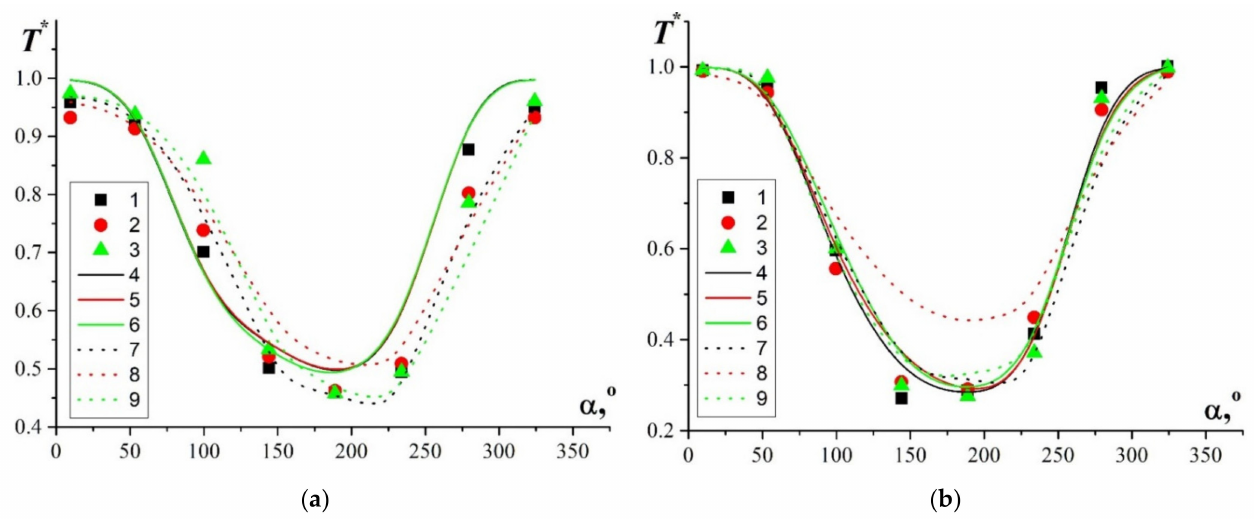
Figure 15. Profiles of the dimensionless temperature T * obtained experimentally [12] (symbols), by the LES approach [12] (dashed lines) and by the RANS approach (solid lines): regime ST1 ( a ), regime ST2 ( b ): 1, 4, 7—Section 9.7 D m ; 2, 5, 8—Section 10.2 D m ; 3, 6, 9—Section 10.7 D